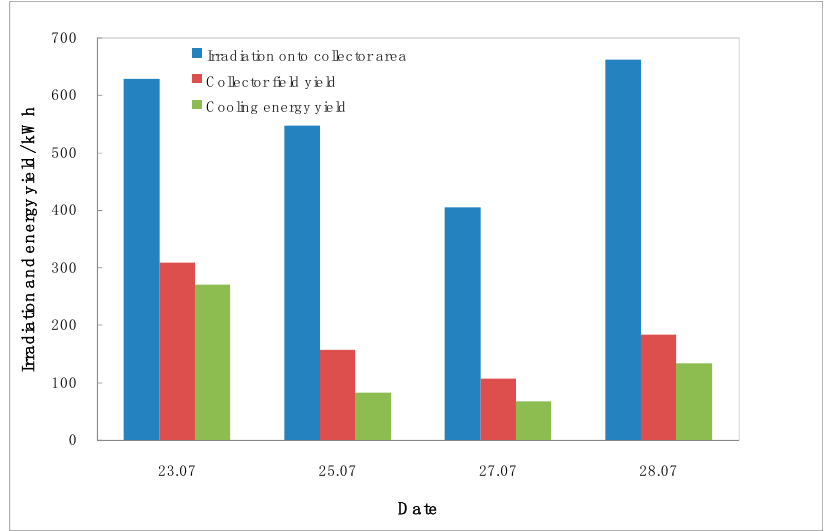
Figure 16. The irradiation onto the collector area, the collector field yield, and the cooling energy yield on 23, 25, 27, and 28 July; the heat pumps were switched off on 25, 27, and 28 July2018.